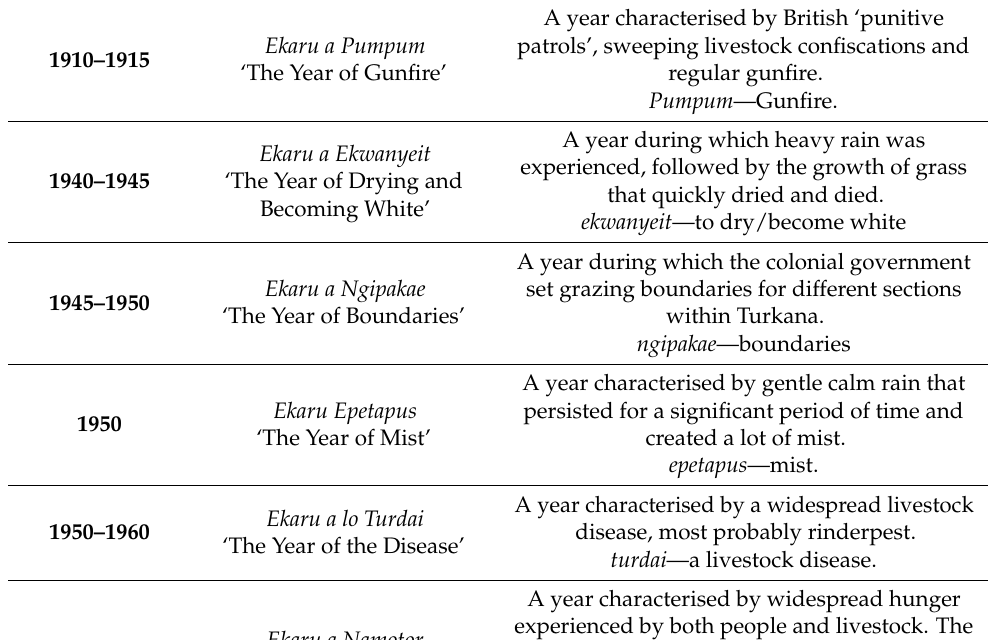
Table 1. Table showing some key years in the recent history of communities in southern Turkana, roughly correlated with years in the Gregorian calendar. Where a date range is given, the Turkana year fell at some point within the range rather than spanning it